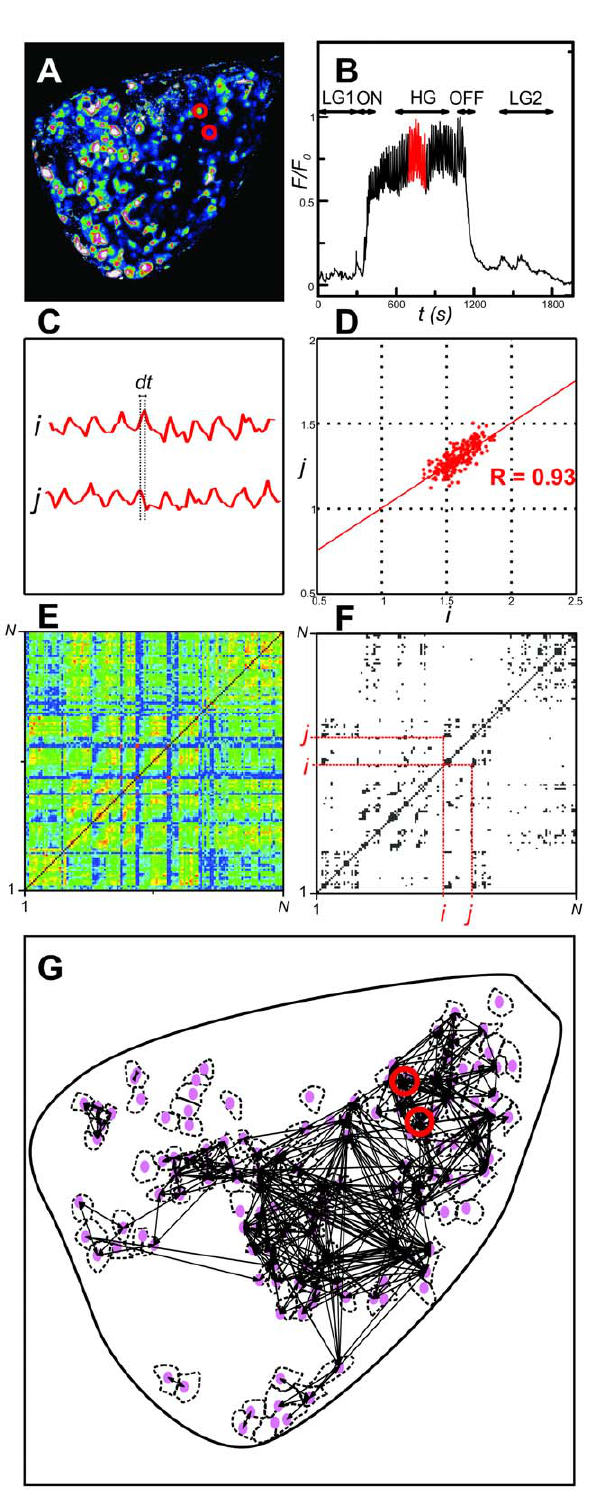
Figure 1. Methodology used to extract functional connectivity patterns from cytosolic Ca 2 + traces. A Image of an islet of Langerhans showing the relative intensity of fluorescence signal during sustained activity (HG). Red circles indicate two cells, i and j , which we regard in continuation. B Temporal evolution of global calcium activity characterized by the mean-field of all beta cells in the islet. In the intervals 0 # t # 150 and 754 # t # 1960 cells were exposed to 6 mM glucose, whereas for 150 # t # 754 a stimulating concentration